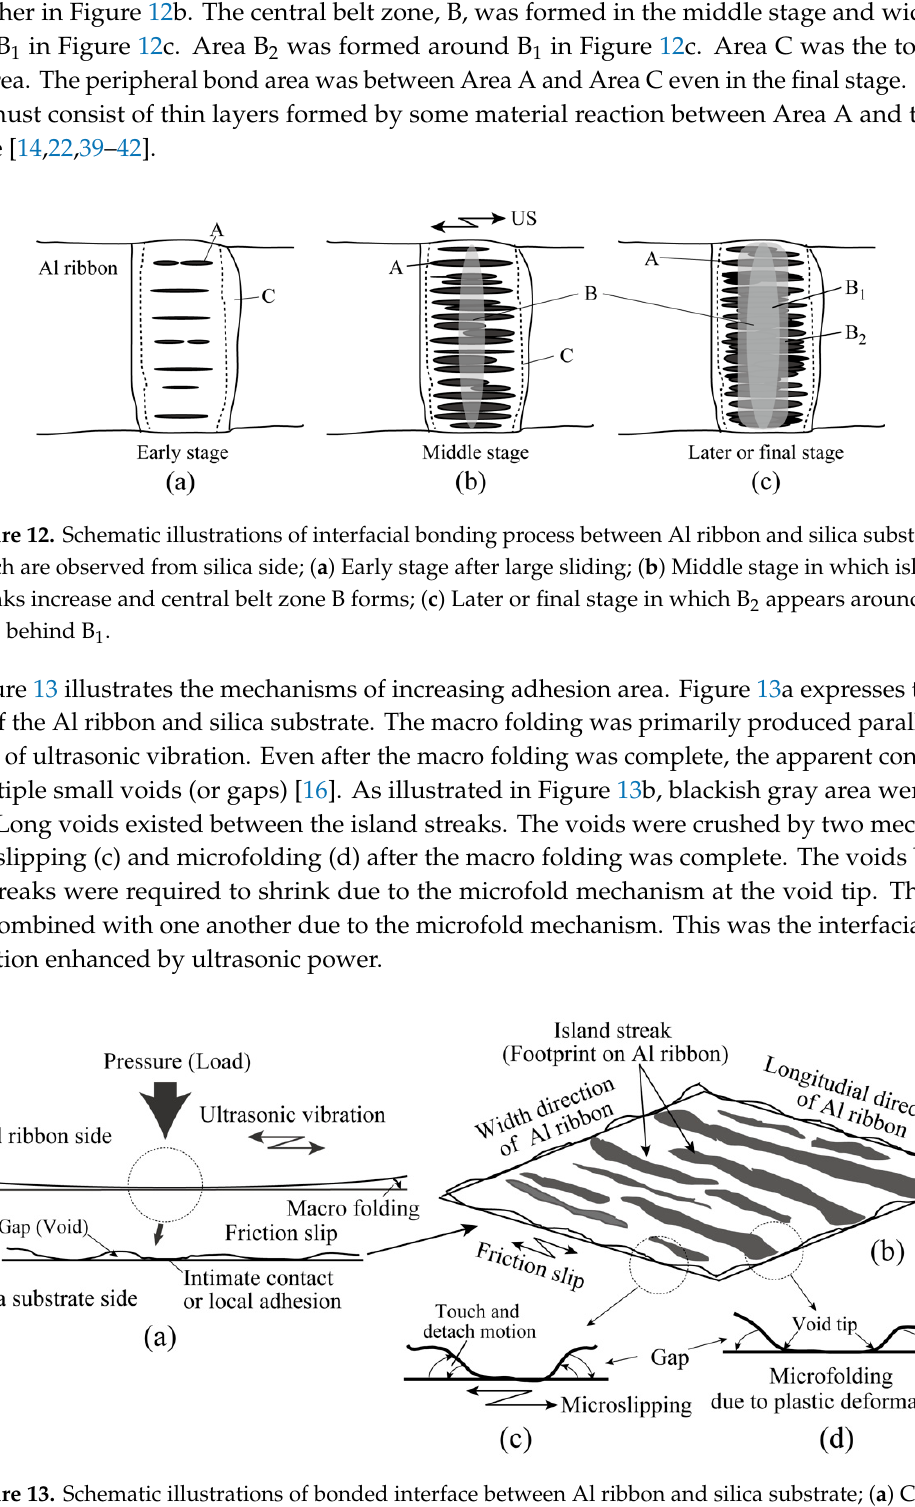
Figure 12. Schematic illustrations of interfacial bonding process between Al ribbon and silica substrate, which are observed from silica side; ( a ) Early stage after large sliding; ( b ) Middle stage in which island streaks increase and central belt zone B forms; ( c ) Later or final stage in which B 2 appears around B 1 . B 2 is behind B 1 .